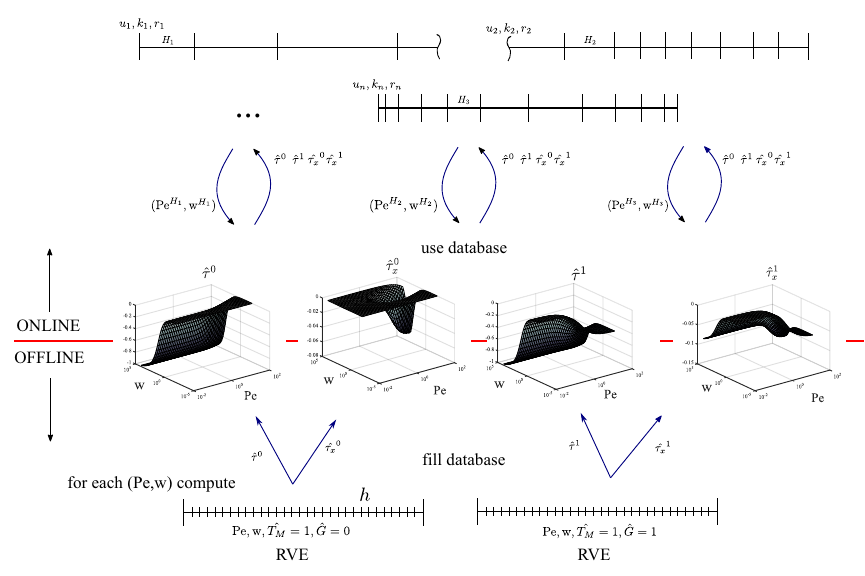
Fig. 3 A graphical description of the actual P-DNS methodology for 1D ADR problems. To fill the database, N Pe × N w × 2 RVE problems were solved. This offline work is done once and used online to solve any coarse scale 1D ADR